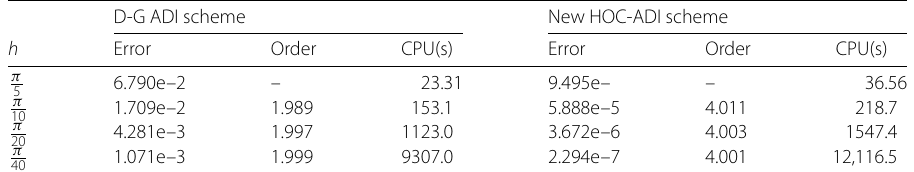
Table 3 Numerical comparison results of the D-G ADI splitting scheme and the new HOC-ADI splitting scheme for Example 2, at T = 2, time step τ =